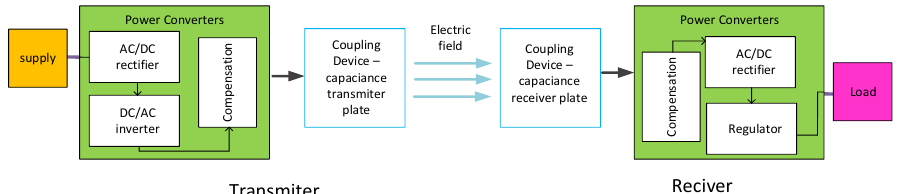
Figure 10. Wireless power transfer—CPT.